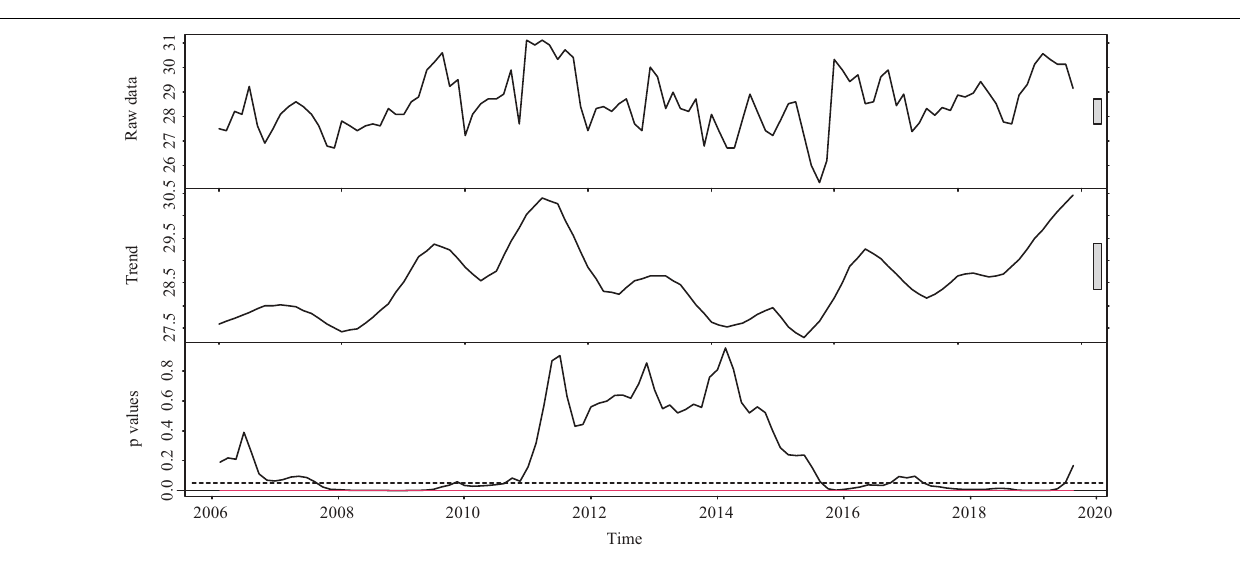
spawning in the present study, the most suitable temperature was closely related to the flood